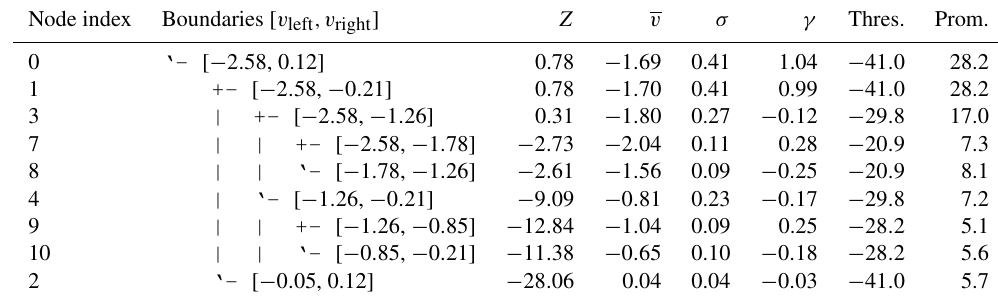
Table 3. Moments for each peak from the KAZR Doppler spectrum depicted in Fig. 2a; similar to Table 2. Node index Boundaries [ v left ,v right ] Z v σ γ Thres. Prom. ‘- [ − 2 . 58,